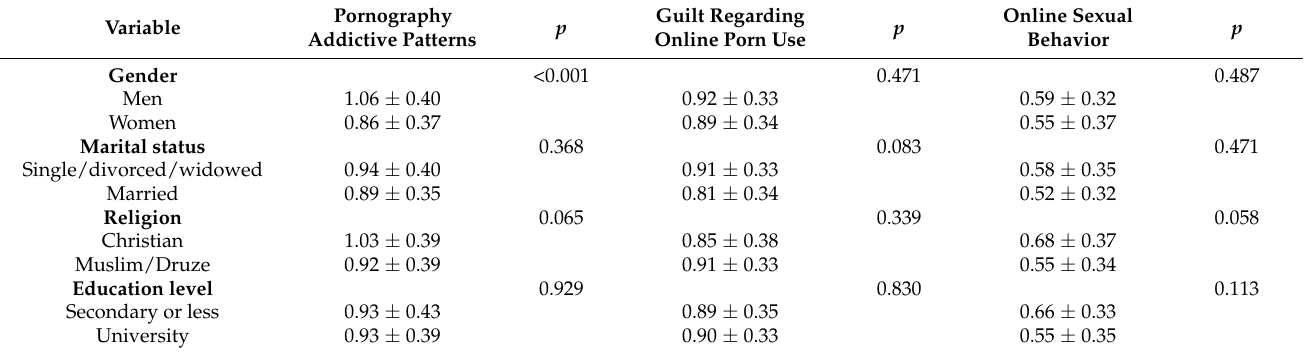
Table 2. Bivariate analysis of categorical variables associated with the three pornography scores.